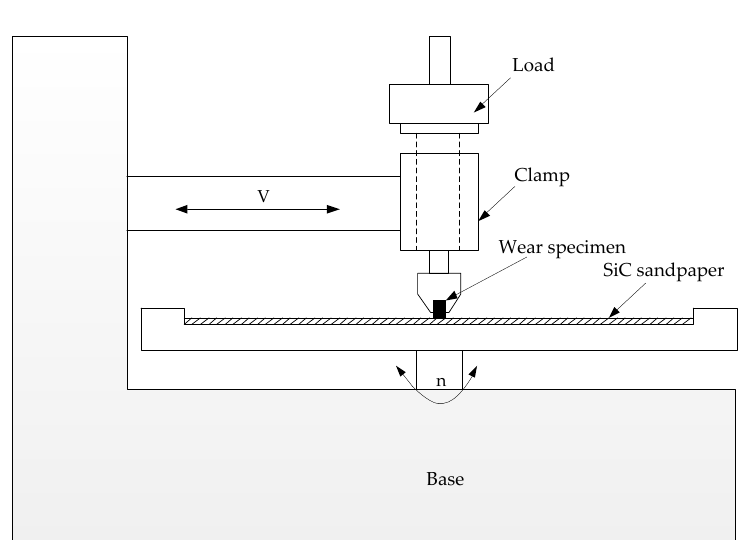
Figure 4. Schematic diagram of the wear experiment.